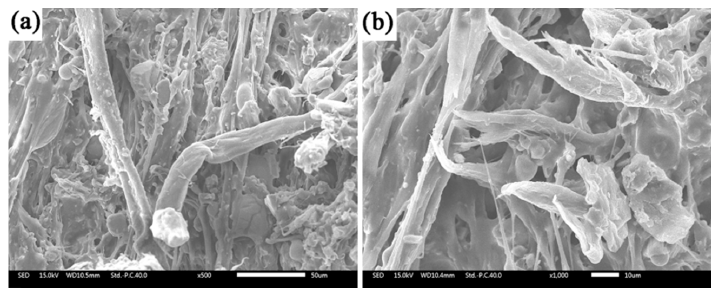
Figure 7. SEM of the sample EPDM/AF 10 fired at 350 °C for 20 min: ( a ) ×500; ( b ) ×1000. The surface structures of the residues of EPDM/AF 0 fired at 600 °C and 800 °C for 30 min are